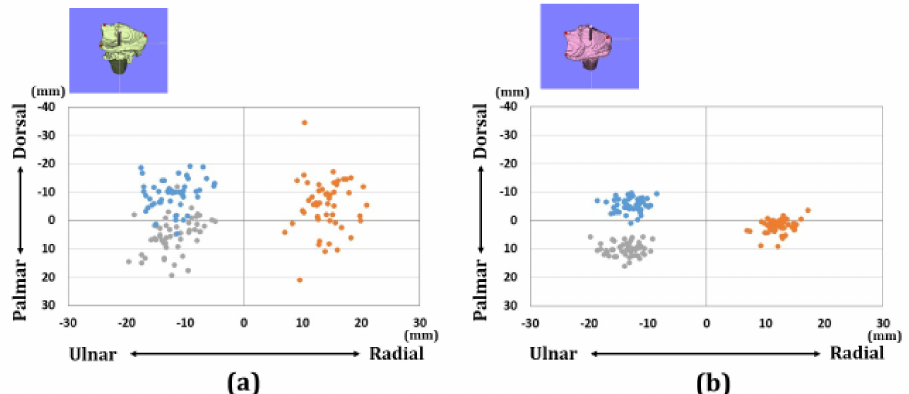
Figure 5. Results of coordinates for the three reference points in the axial plane. ( a ) Results of coordinates for the preoperative image. ( b ) Results of coordinates for the postoperative image. The orange dots indicate the radial styloid process: reference point (1). The gray dots indicate the sigmoid notch volar edge: reference point (2). The blue dots indicate the sigmoid notch dorsal edge: reference point (3).